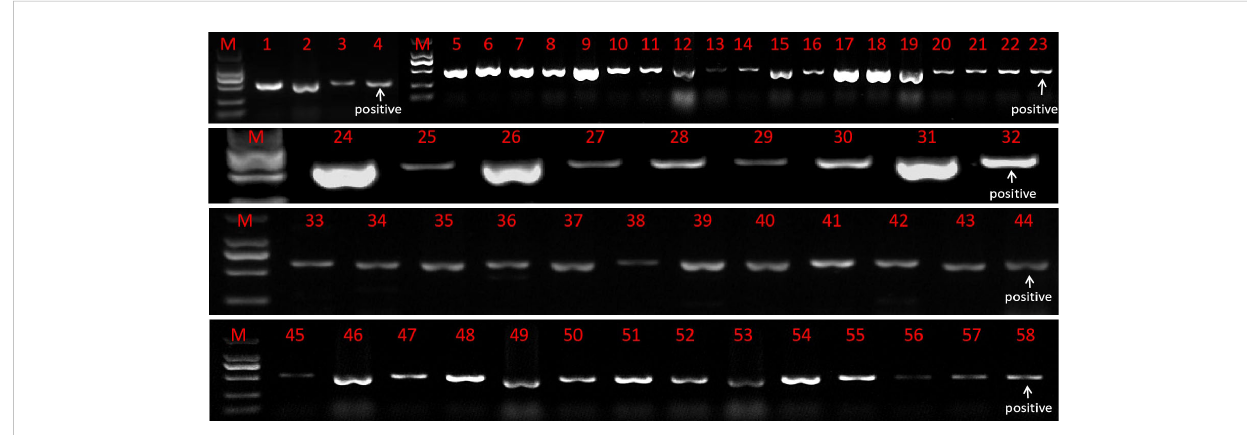
FIGURE 5 The identi fi cation results of some genetically transformed strains. “ M ” is the DL2000 DNA marker. Numbers 4, 23, 32, 44, and 58 were all positive controls. Numbers 1 to 3 represent the CR- Bol gene detected in 19B42, numbers 5-22 represent the PTCK303- 031350 gene detected in 19B42, numbers 24-31 represent the PHG- CRa gene detected in 18LH, numbers 33-40 represent the PTCK303- 029100 gene detected in 19B42, numbers 41-43 represent the PTCK303- 029100 gene detected in 18Y8, numbers 45-50 represent the PHG- 031350 gene detected in 19B42, and numbers 51-57 represent the PHG- 031350 gene detected in 18B3.